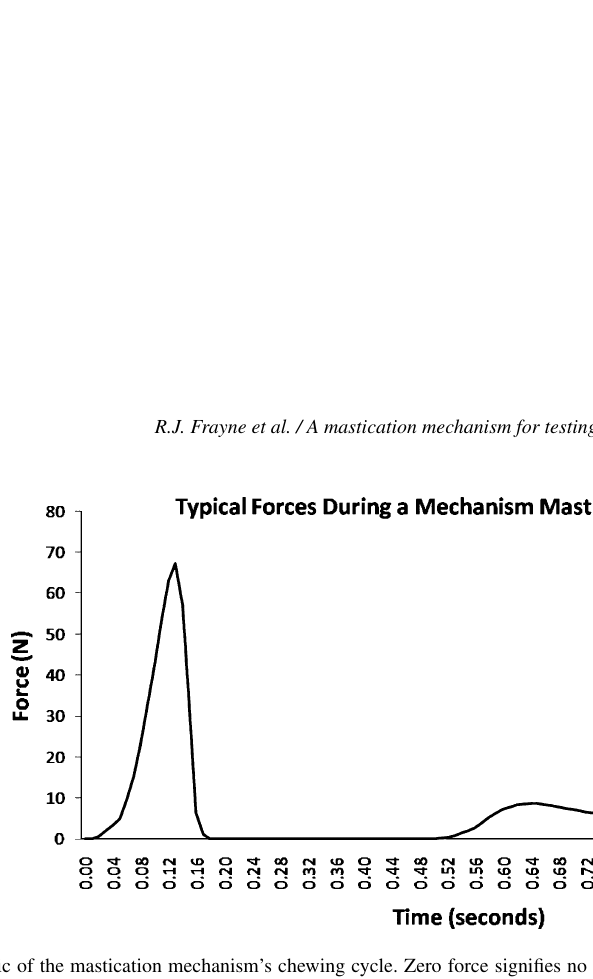
Fig. 4. Schematic of the mastication mechanism’s chewing cycle. Zero force signifies no contact between the implant and the articular emi- nence/fossa. The prolonged loading following the translational phase is due to forces from the condyle sliding along the slope of the eminence. The amount of contact between the implant and superior structures depends on the slope of the eminence, size and shape of the condyle,